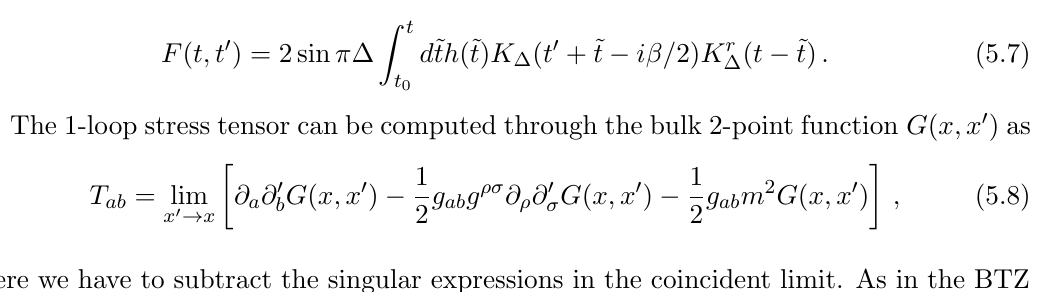
= t 1 . The R=L (cid:6) t 0 at the (cid:0)